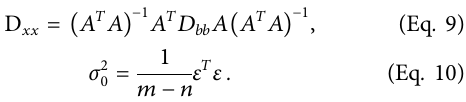
Frontiers in Earth Science |